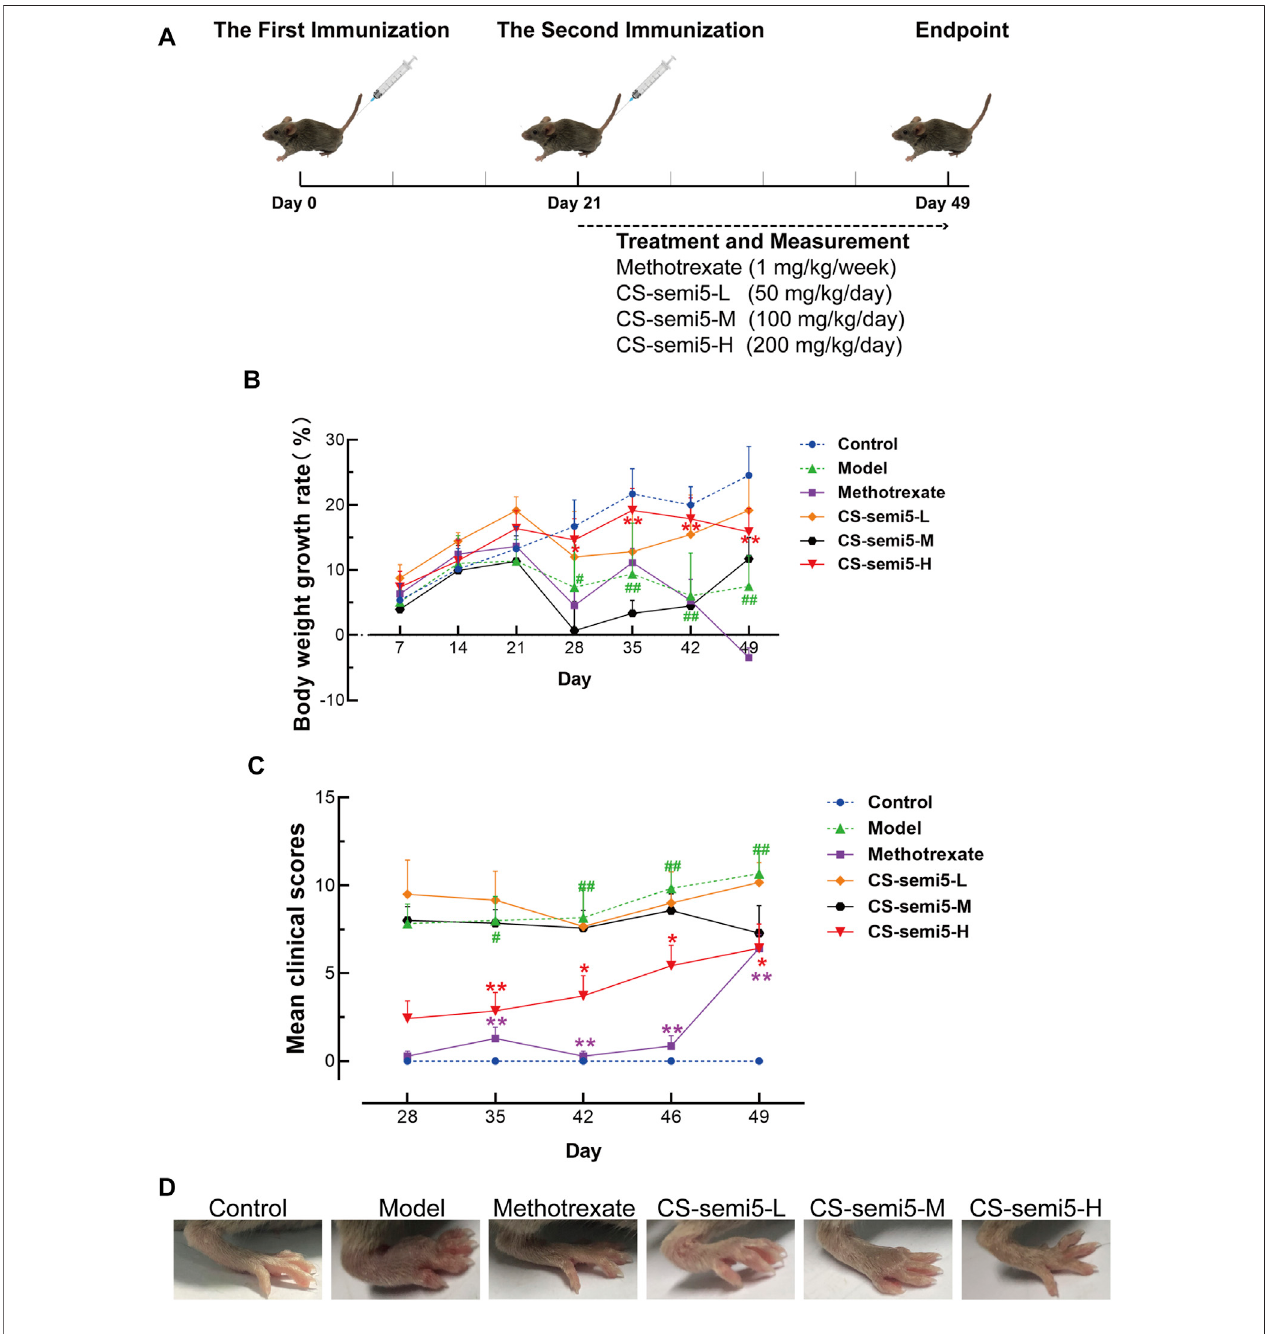
FIGURE 1 | CS-semi5 inhibits the development and progression of collagen-induced arthritis (CIA). (A) Schematic diagram of CIA model establishment. (B) Body weight growth rate was measured weekly. (C) The severity of arthritis swelling was evaluated by mean clinical scores weekly after second immunization. (D) Hind paw swelling was photographed on day 49. n (cid:1) 7. # p < 0.05 and ## p < 0.01 compared with Control group; * p < 0.05 and ** p < 0.01 compared with Model group.